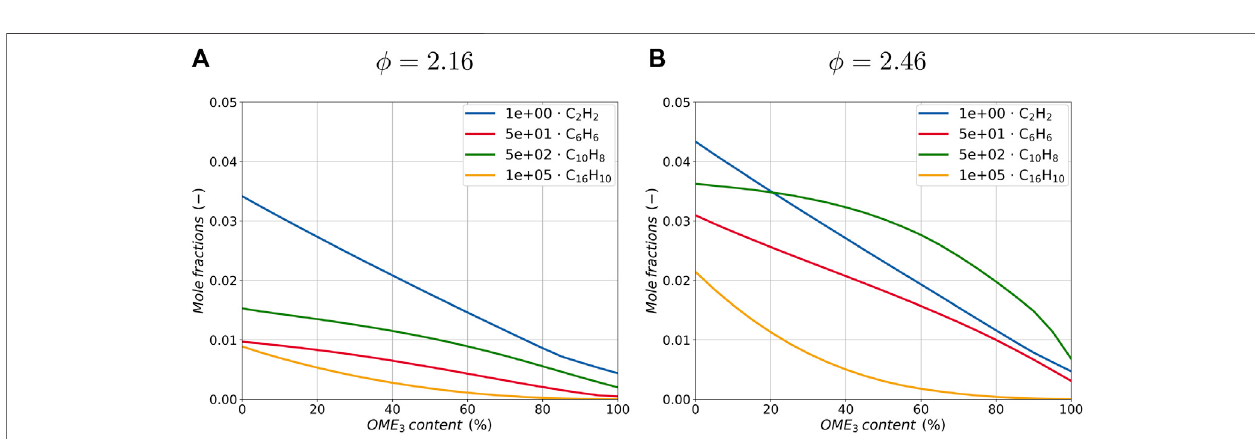
FIGURE 3 | Maximum peak of species mole fractions in the fl ame with an equivalence ratio of ϕ (cid:1) 2.16 (A) and ϕ (cid:1) 2.46 (B) for different OME 3 blending ratios. The peak values of the aromatic species C 6 H 6 , C 10 H 8 and C 16 H 10 are scaled by the factors of 5.0 e 1, 5.0 e 2 and 1.0 e 5 for better clarity.